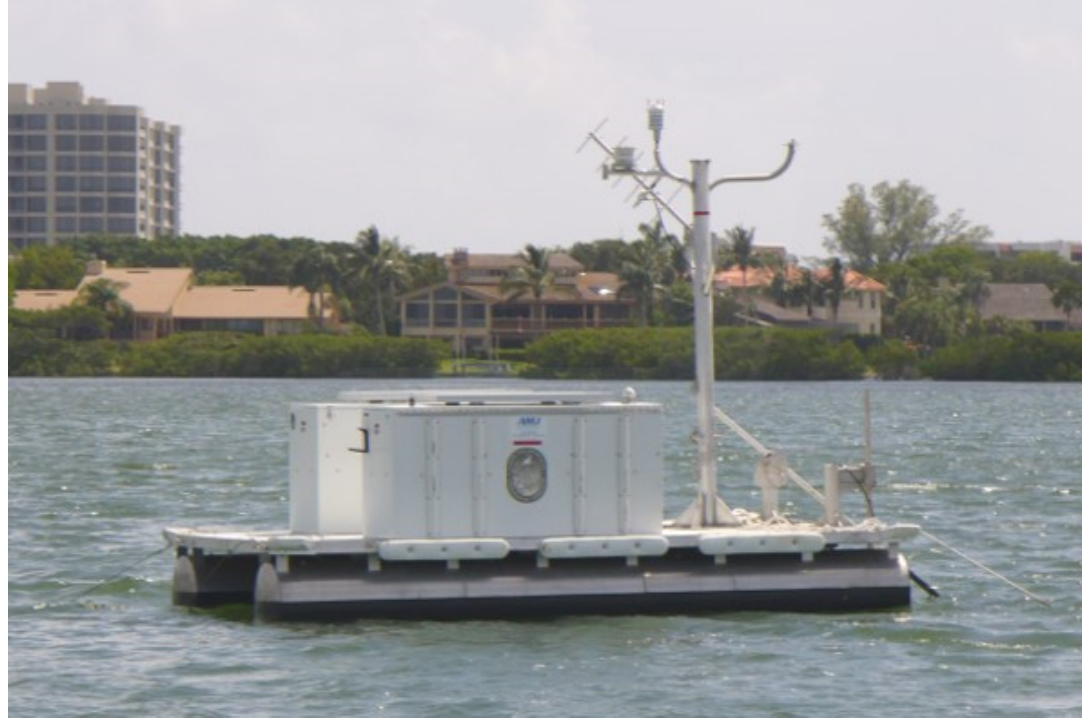
Figure 2. The MERHAB Autonomous Research Vessel In-situ (MARVIN) deployed in Sarasota Bay. Table 1. Instruments, with associated parameters measured, final output, and sampling depth, installed on the MARVIN platform during the 2009 Sarasota Bay deployment.